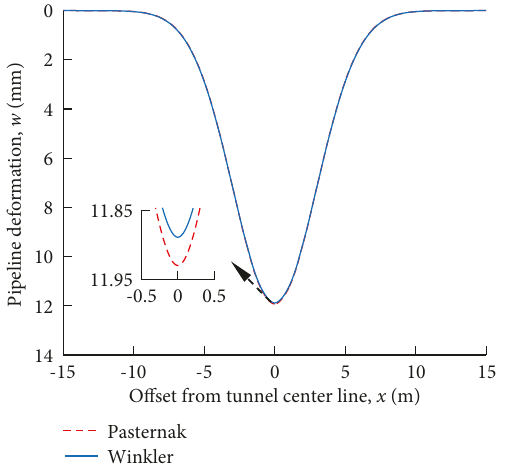
Figure 7: Comparison of analytical solution and other method.